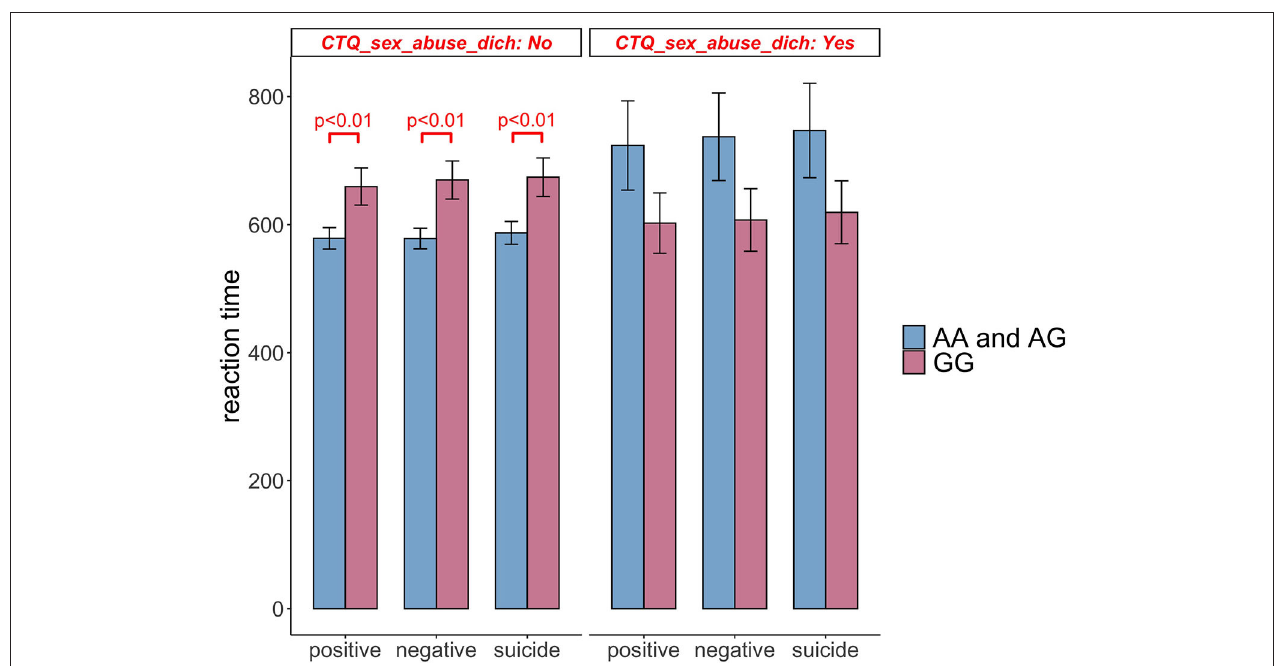
FIGURE 5 | Comparison of Stroop task reaction time between patients having rs211034 allele A and patients not having rs211034 allele A, within the group of subjects exposed to Sexual Abuse and the group of subjects not exposed to Sexual Abuse separately. Raw scores before covariate adjustment are presented, and error bars represent standard error of the mean. Significant results are obtained from regression models adjusting for age, gender and education